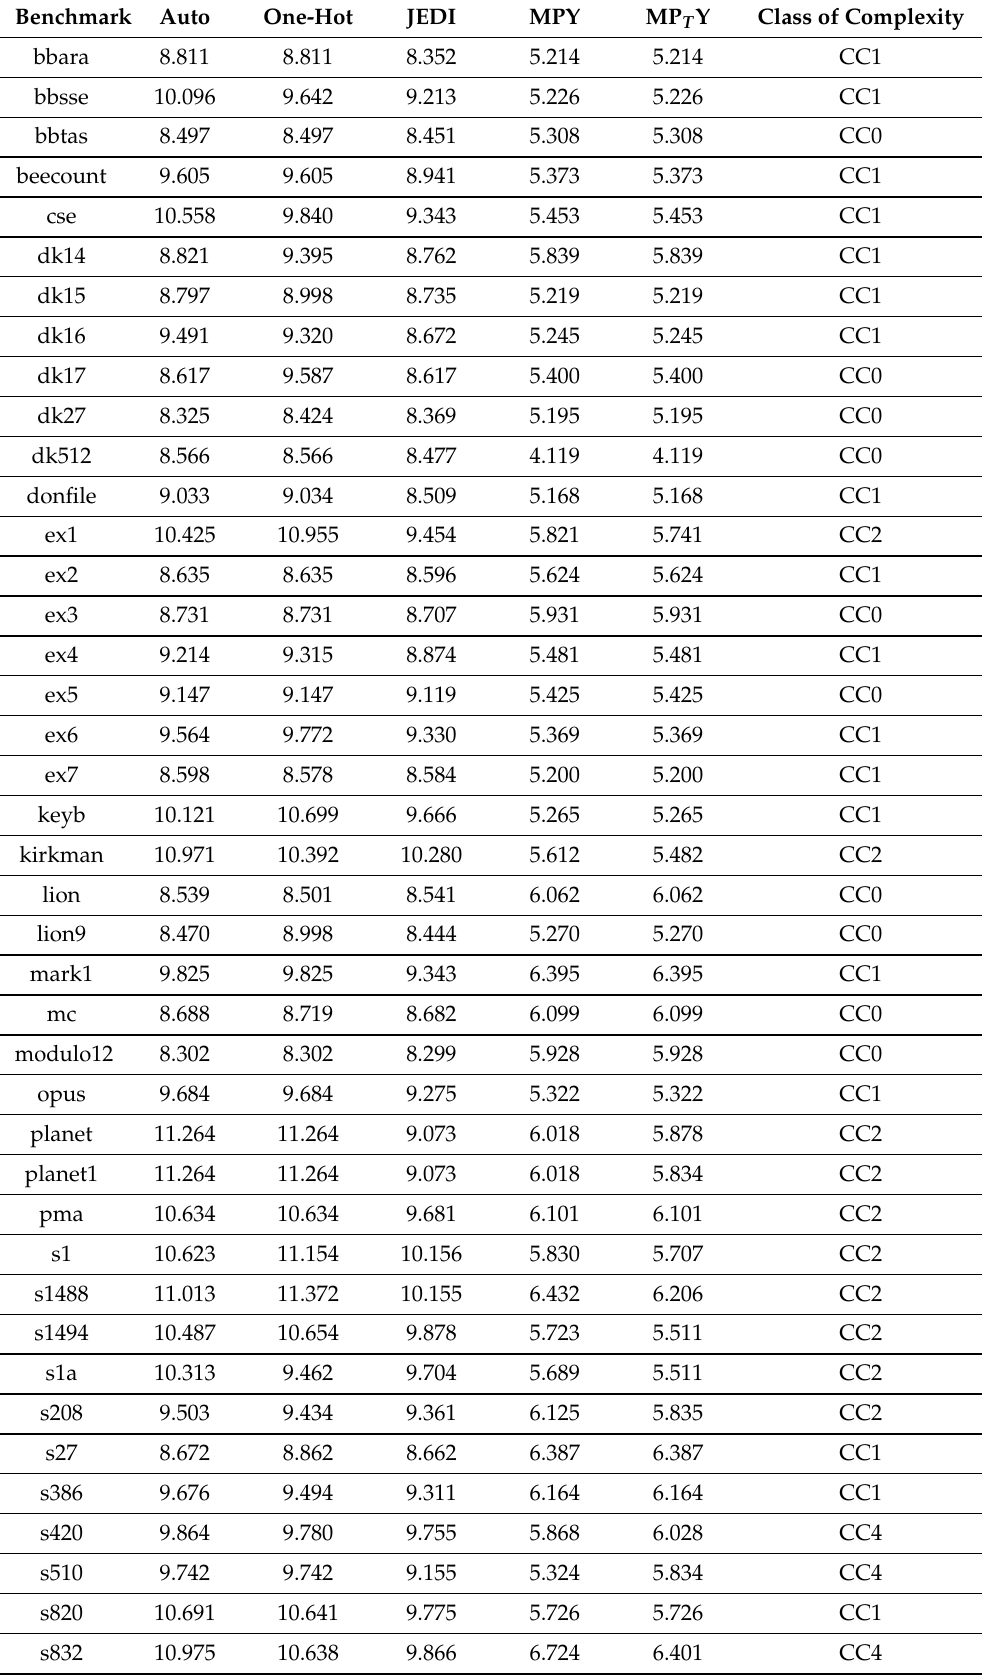
Table 11. Experimental results (the cycle time,